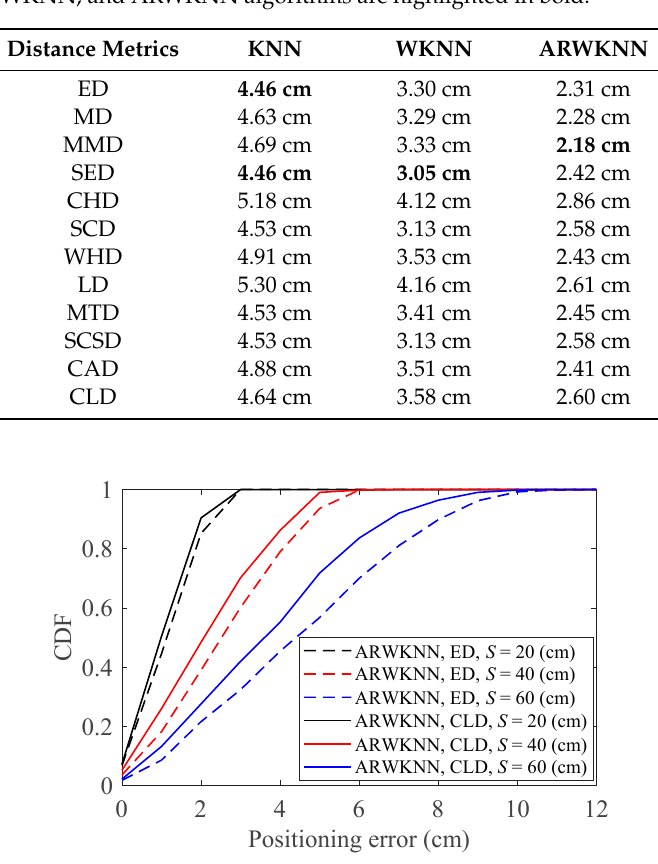
Table 5. In 3-D, the impact of distance metrics on the average positioning error with K max = 8, best values for KNN, WKNN, and ARWKNN algorithms are highlighted in bold.